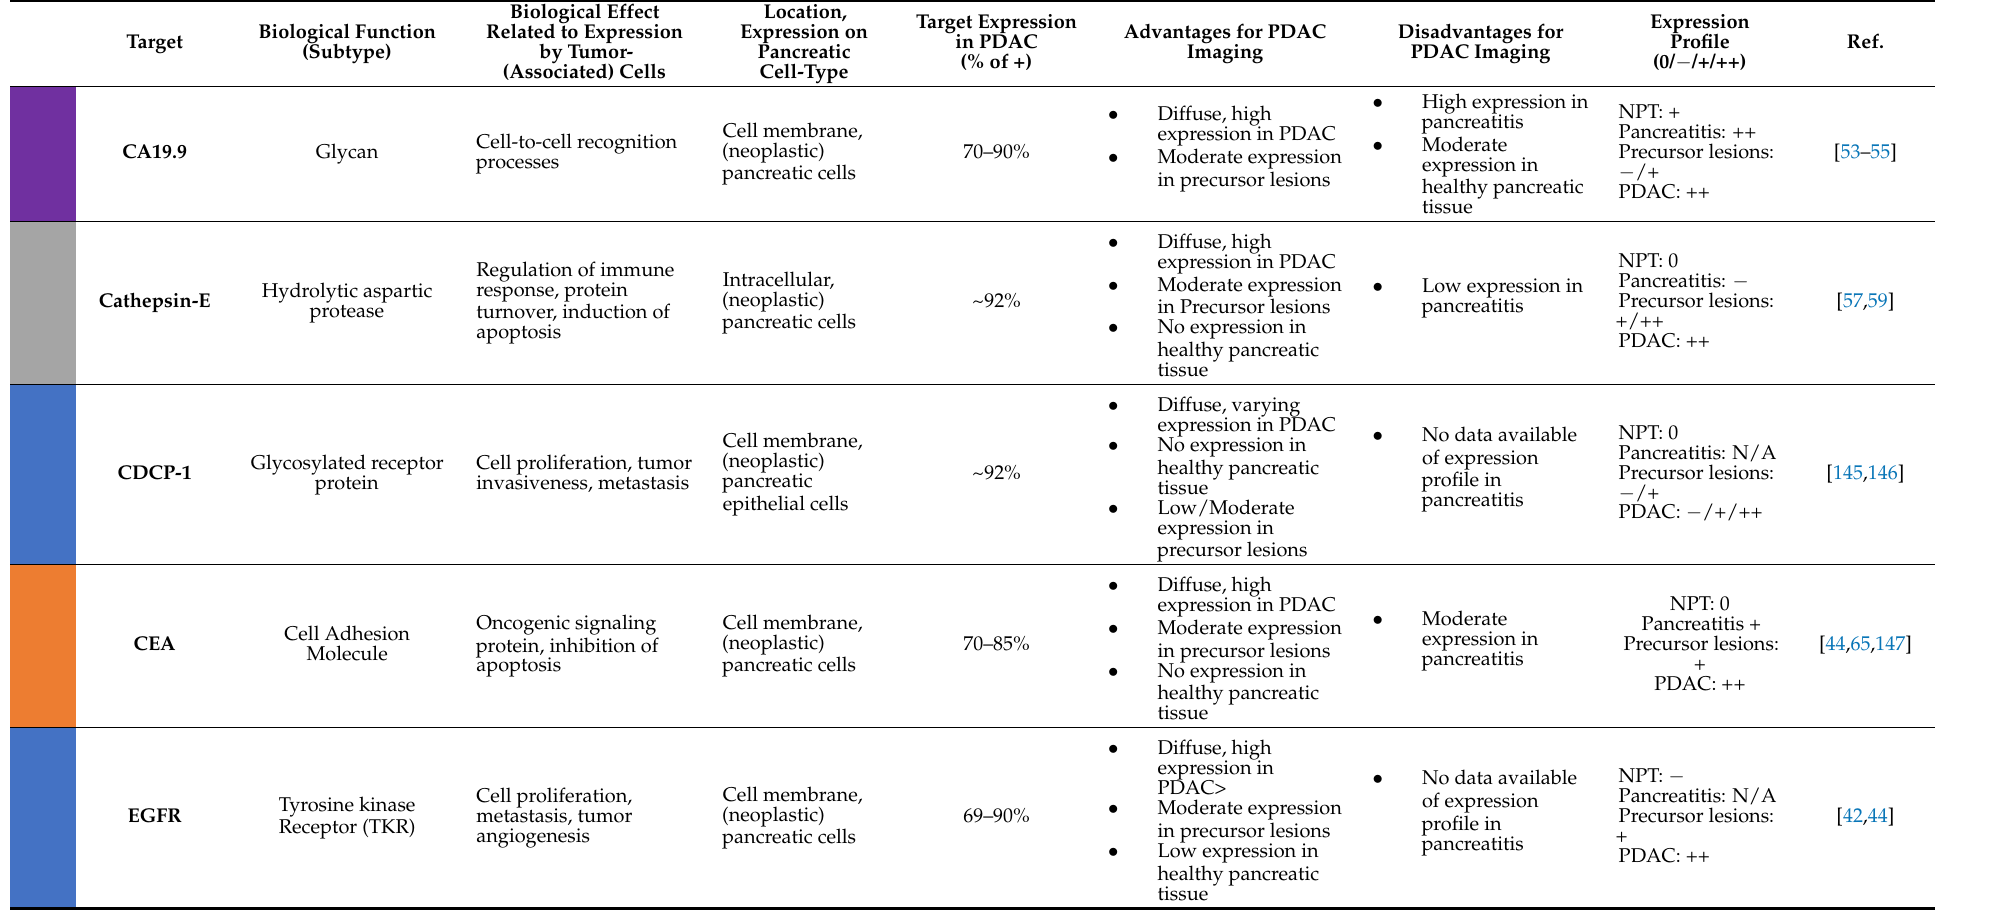
Table 1. Overview of (pre)clinical evaluated PDAC biomarkers for molecular imaging (PET/CT